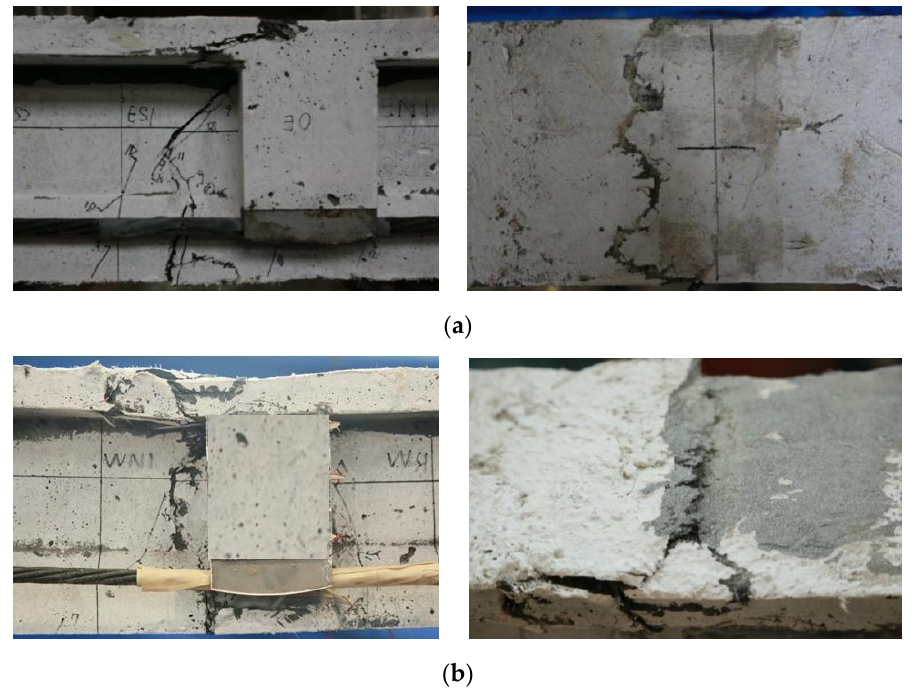
Figure 5. Typical failure patterns of specimens: ( a ) tension controlled failure of the fully prestressed specimen; ( b ) compression controlled failure of the partially prestressed specimen.